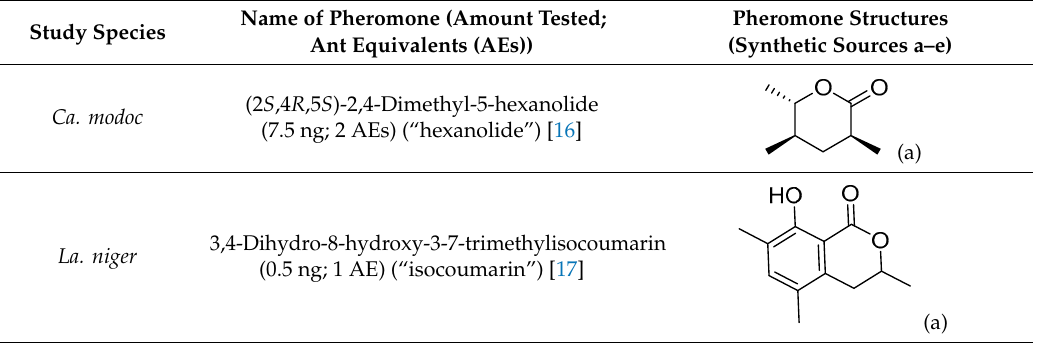
Table 1. List of trail pheromones (and select species producing them) comprising the six-trail pheromone blend (6-TPB) tested in circular trail bioassays (Figure 1) and in electrophysiological